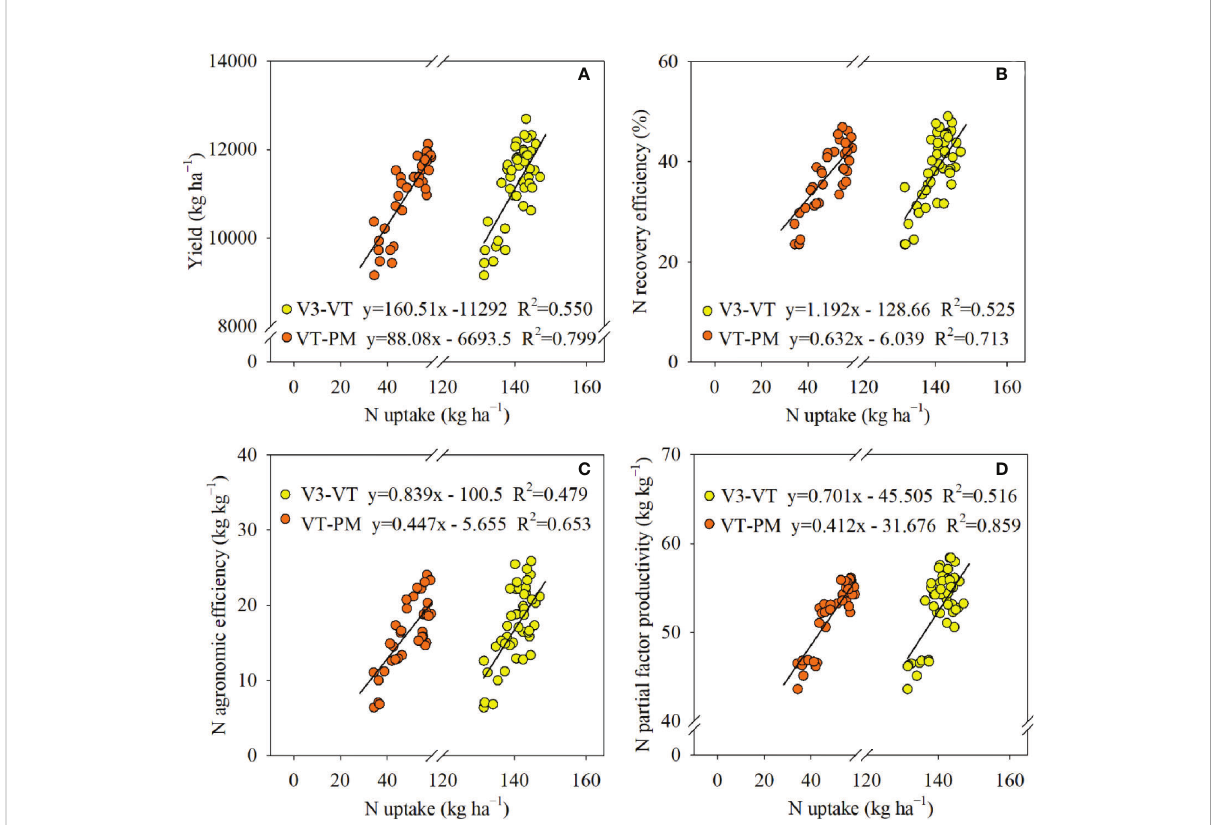
FIGURE 6 Linear regressions between N uptake and yield (A) , N recovery ef fi ciency (B) , N agronomic ef fi ciency (C) , and N partial factor productivity (D) before (V3 – VT) and after (VT – PM) tasseling stages of maize in 2018, 2019, and 2020. Growth stages: V3, third-leaf; VT, tasseling; PM, physiological maturity.